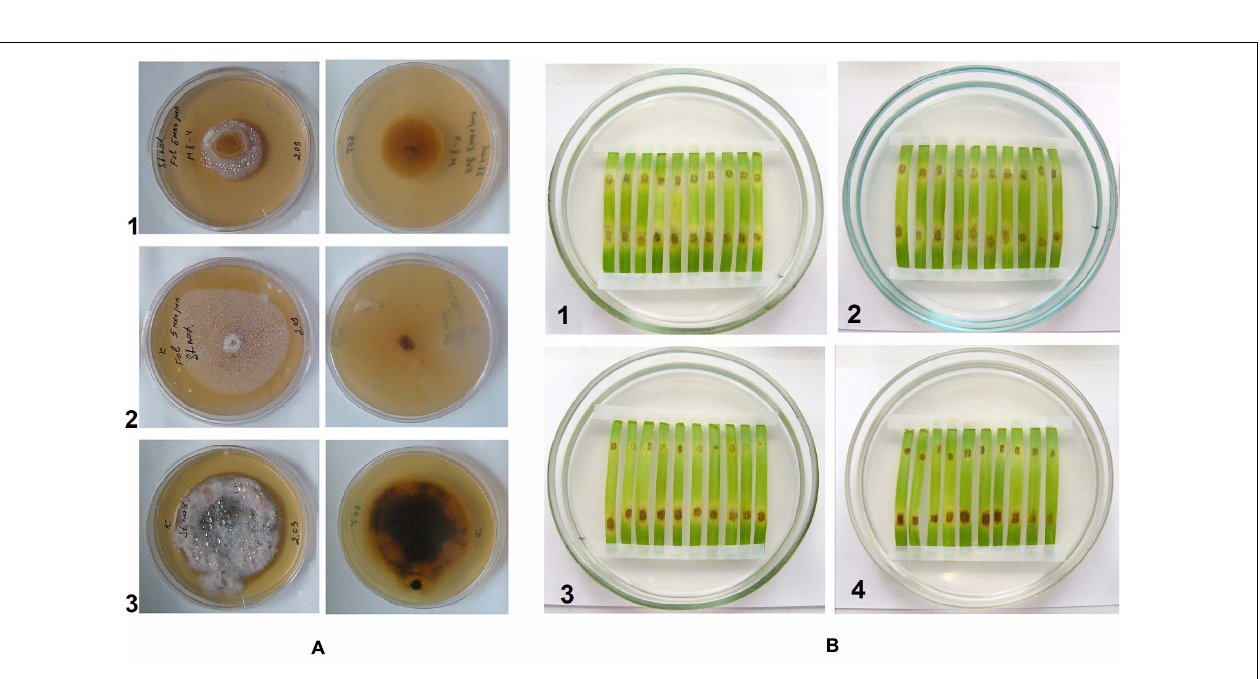
FIGURE 4 | (A) Colonies of tebuconazole-tolerant mutant (1) and wild (2, 3) strains of Parastagonospora nodorum , grown on potato-dextrose agar containing Folicur R (cid:13) (1 and 2) or not containing Folicur R (cid:13) (3) Photos in the right column show fungal colonies on reverse side of the plates. (B) P. nodorum blotch lesions on leaf fragments cut from detached wheat leaves. (1, 2, 4) , tebuconazole-tolerant mutant; (3) , wild strain. Upper (distal) portions of leaf fragments are inoculated with a suspension of conidia (10 6 /ml) supplemented with Folicur R (cid:13) alone (1) , thymol alone (2) or their mixture (3 and 4) containing the same dosages as used for (1, 2) . Lower (basal) portions of leaf fragments are inoculated with conidia suspended in water to the same final concentration of 10 6 per ml.